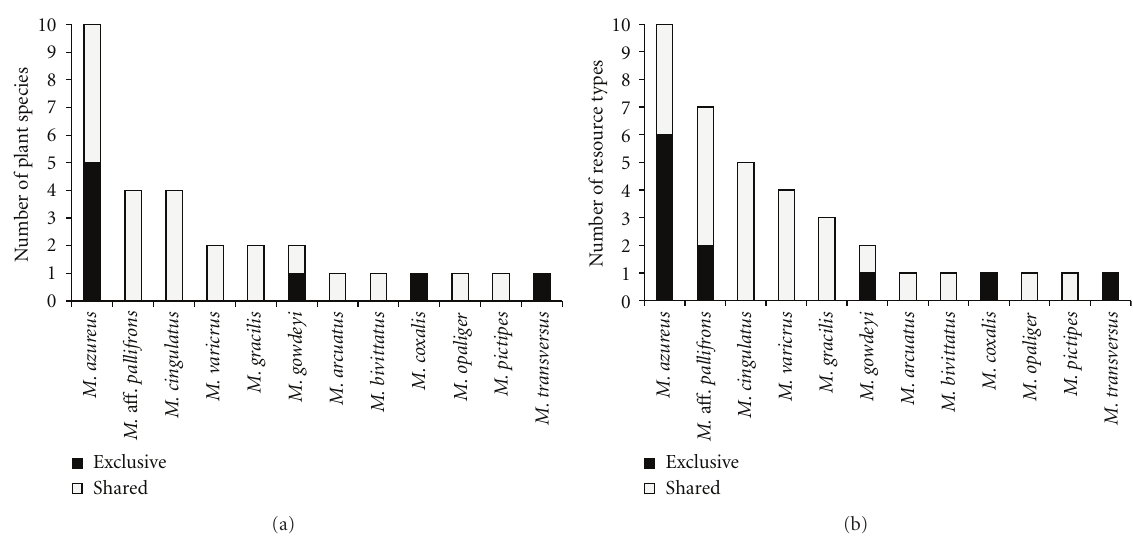
Figure 2: Number of plant species (a) and resource types (b) used by each Merosargus species found in samples collected at the Parque Estadual do Rio Doce (PERD), Minas Gerais, Brazil, between October 2001 and October 2004. Black bars represent plant species/resource types used by a single species, and open bars those shared with at least one species.